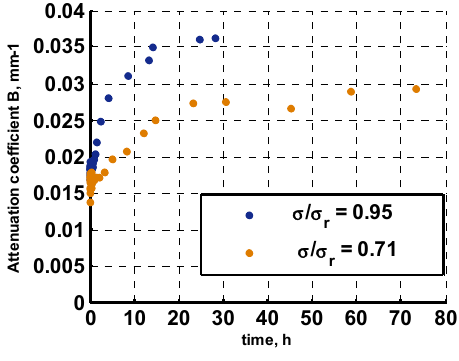
Figure 9. Critical times obtained with the minimum value of R AE and the optimum t sart for the Benioff law obtained with the OCM method.